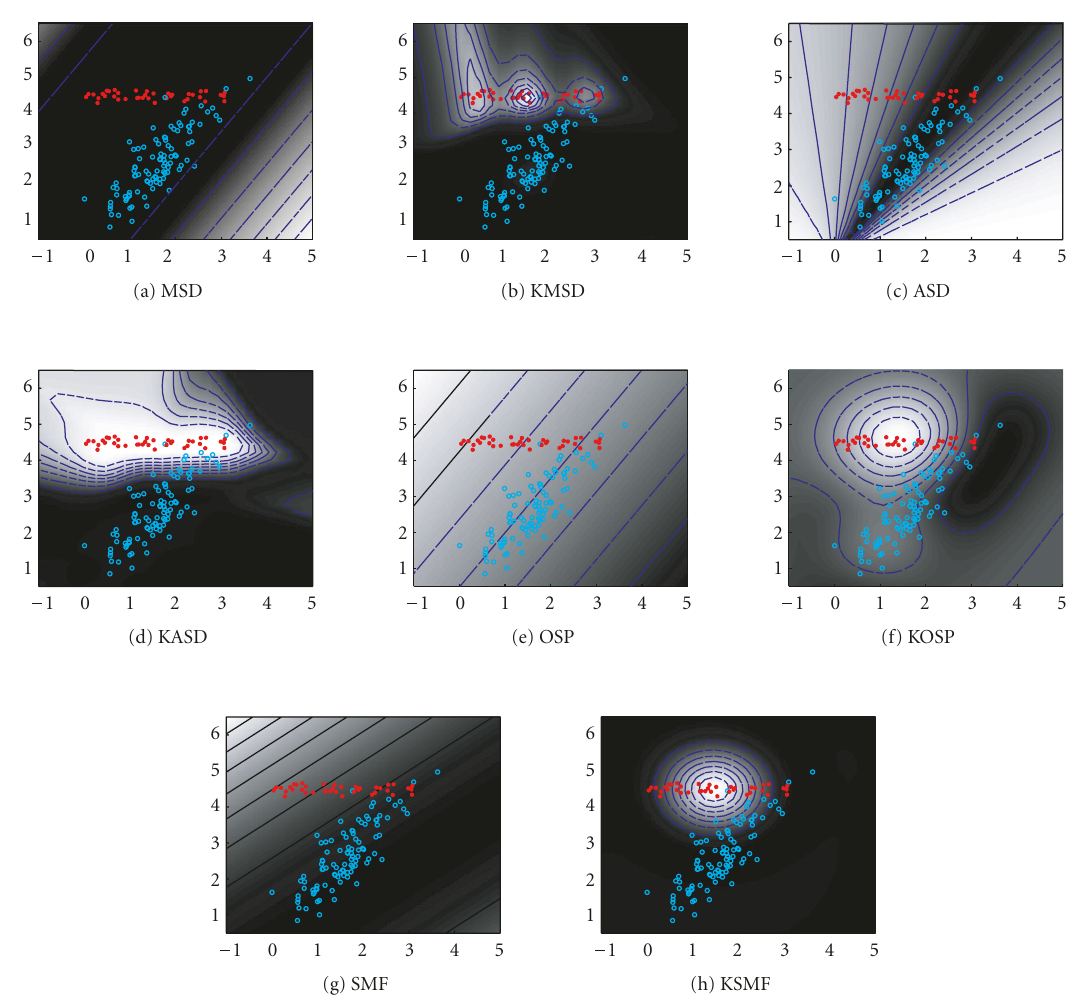
Figure 1: Contour and surface plots of the conventional matched signal detectors and their corresponding kernel versions on a toy dataset (a mixture of